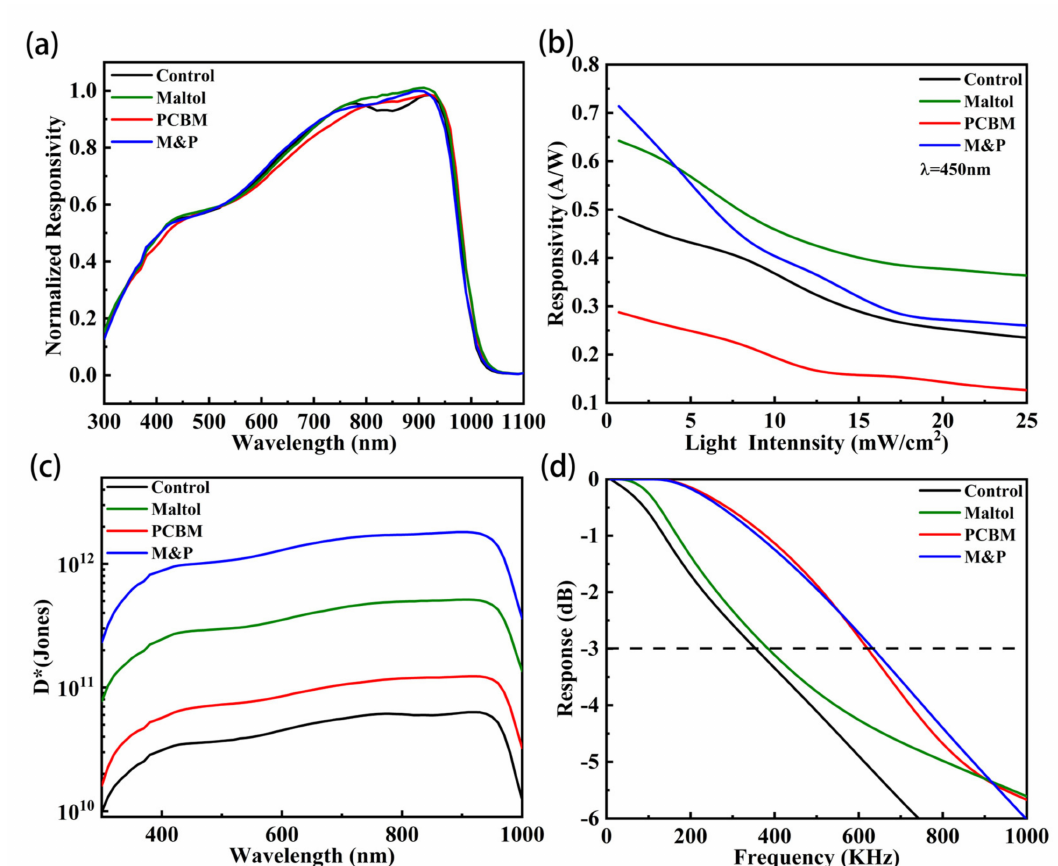
Figure 5. Photodetection performance of the four different perovskite photodetectors. ( a ) Responsivity spectra, ( b ) Light intensity dependent responsivity, ( c ) Specific detectivity, and ( d ) Frequency